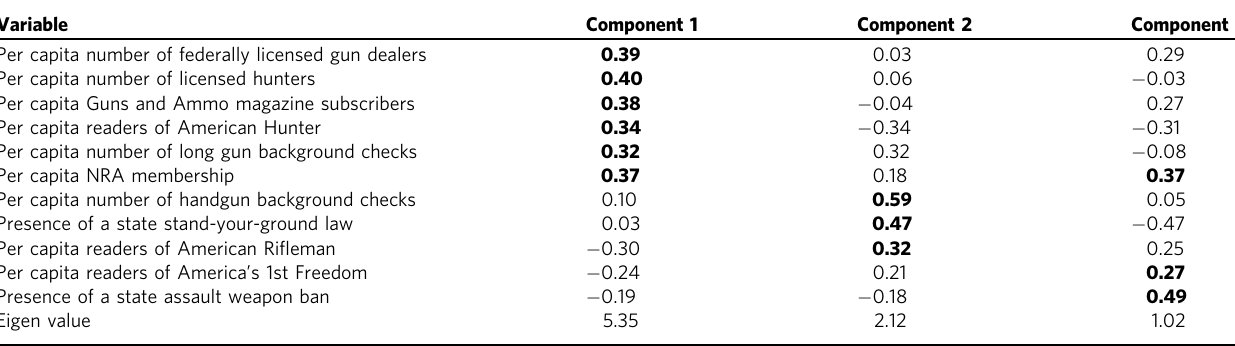
Table 1 Principal component